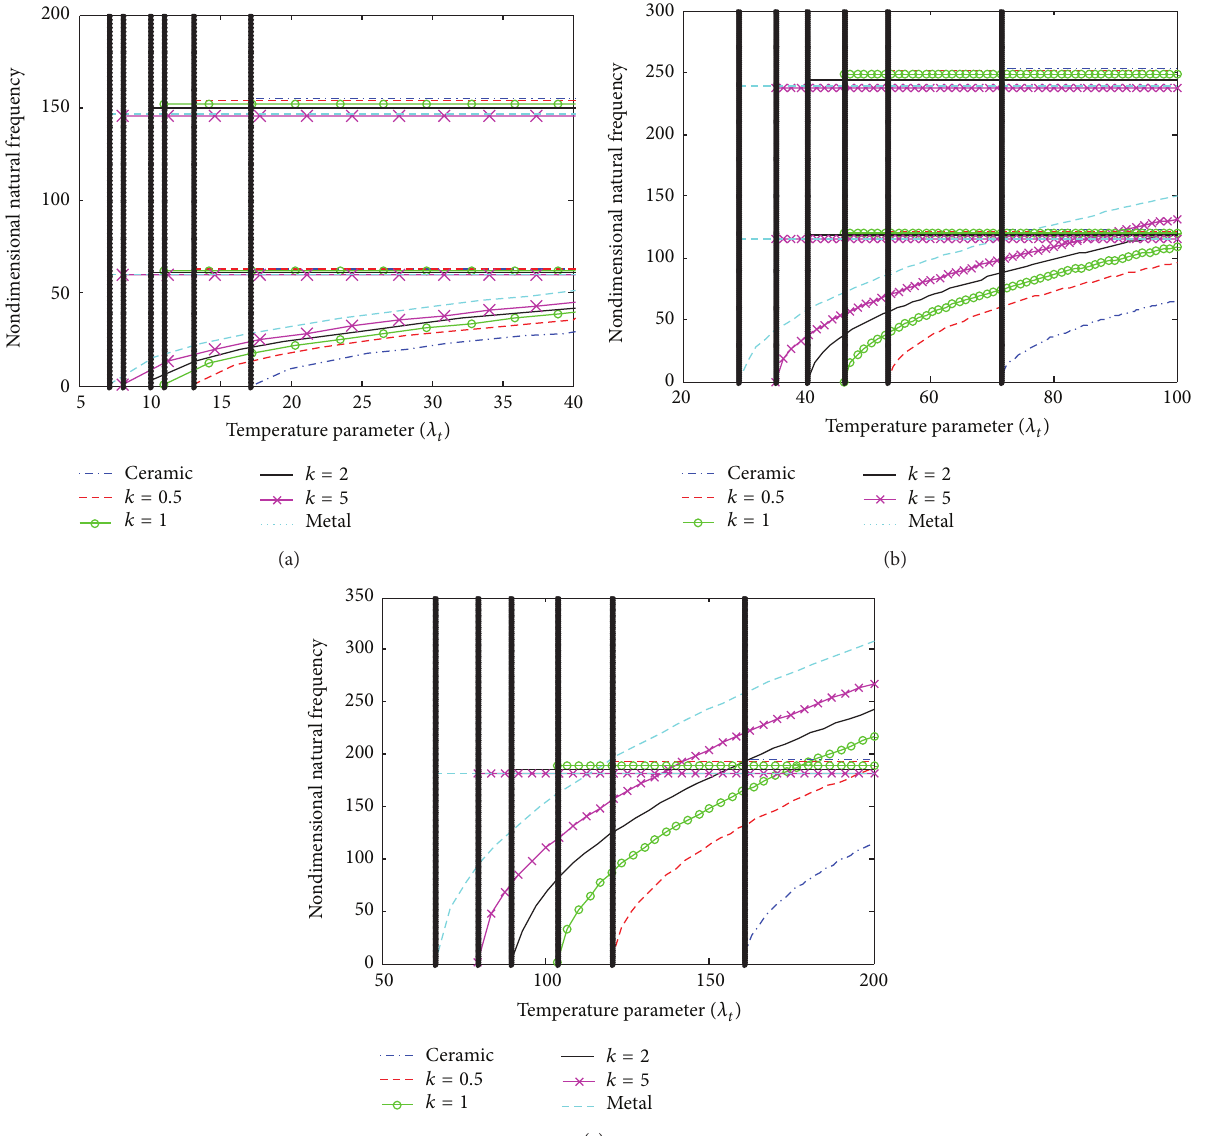
Figure 10: Variation of the nondimensional fundamental natural frequency of vibration around the (a) first, (b) second, (c) third buckling mode with the temperature parameter for a simply supported-simply supported FG beam with different values of 𝑘 ( 𝑙/ℎ = 1 , 𝐿/ℎ = 40 ).